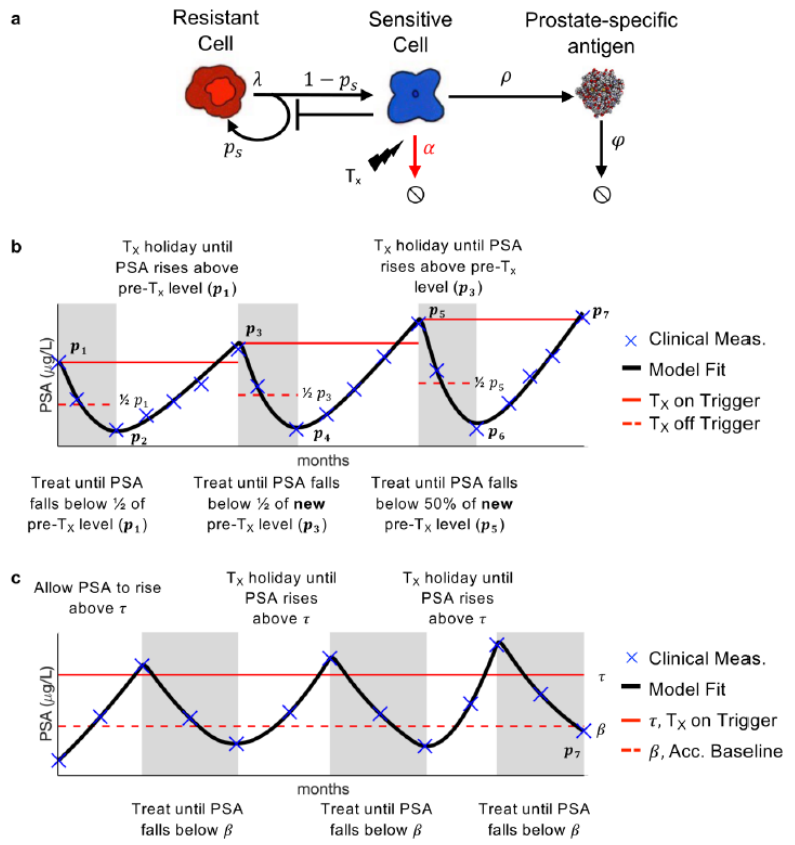
Figure 1. Model and treatment designs. ( a ) Model schematic of treatment resistance stem cells, sensitive non ‐ stem cells, and prostate ‐ specific antigen interactions. ( b ) Adaptive therapy treatment design. ( c ) Range ‐ bounded adaptive therapy treatment design.